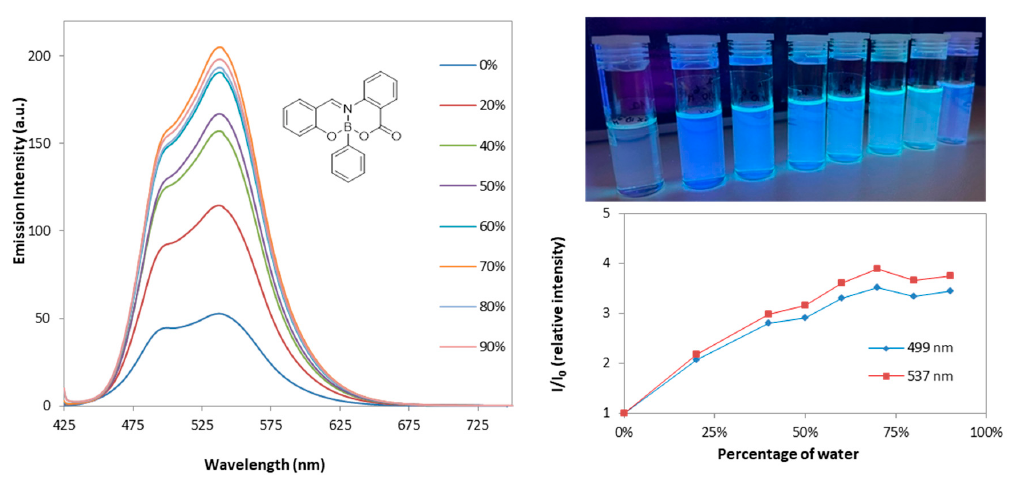
Figure 3. Emission spectra of boron complex 1a in THF–water solutions ( left ); photographs of the solutions/suspensions under UV light (365 nm) and relative emission intensities as a function of the percentage of water ( right ).